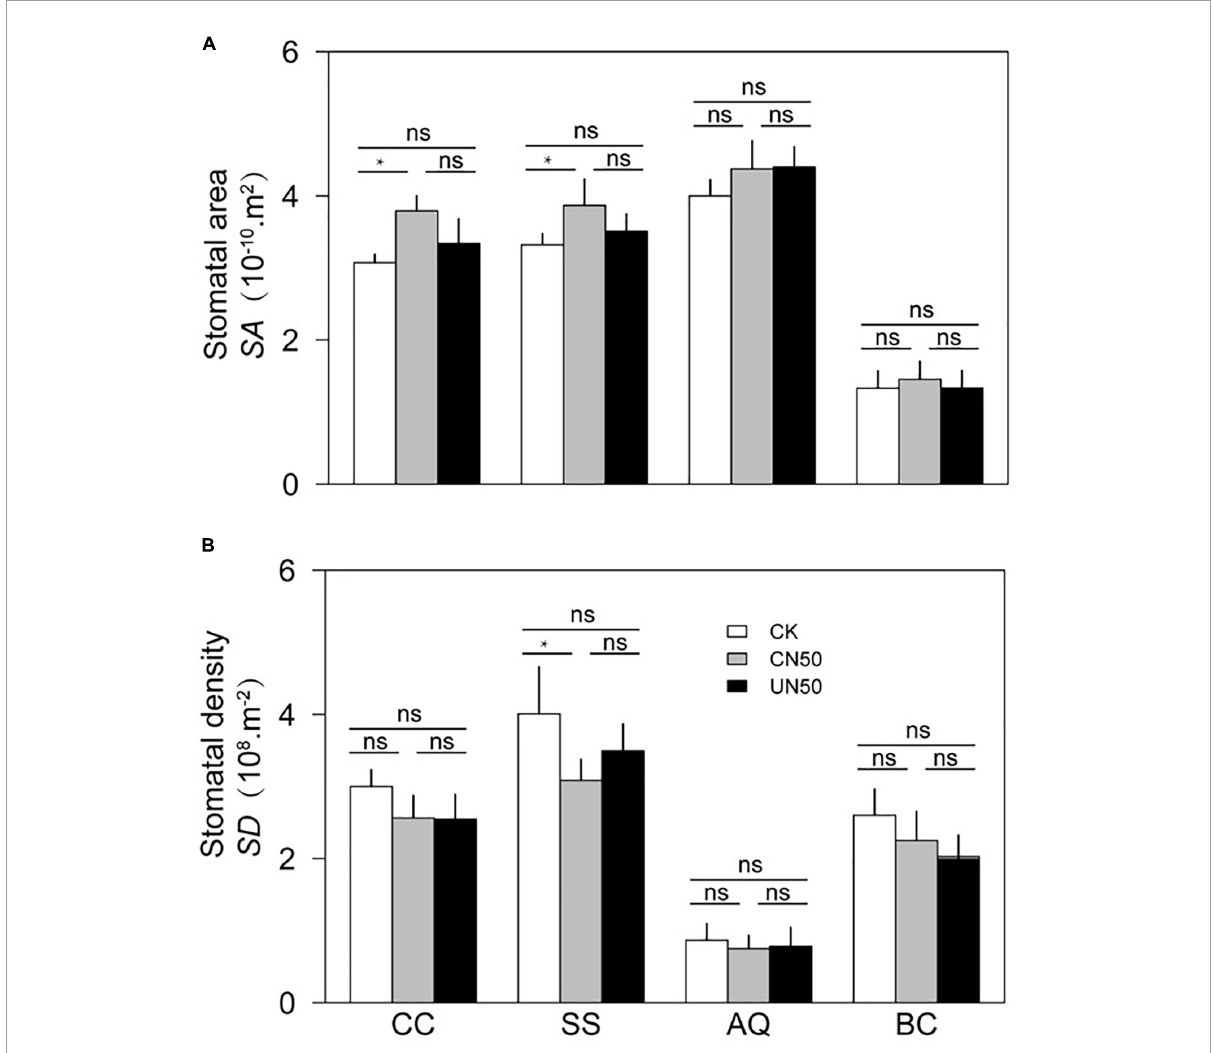
FIGURE3 Stomatal area (A) and stomatal density (B) of two canopy tree species ( CC and SS ) and two understory species ( AQ and BC ) under control conditions (CK), canopy N addition (CN), and understory N addition (UN). CC , SS , AQ , and BC are Castanopsis chinensis , Schima superba , Ardisia quinquegona , and Blastus cochinchinensis , respectively. ns: no significant difference; *Significant difference at P < 0.05 (nested